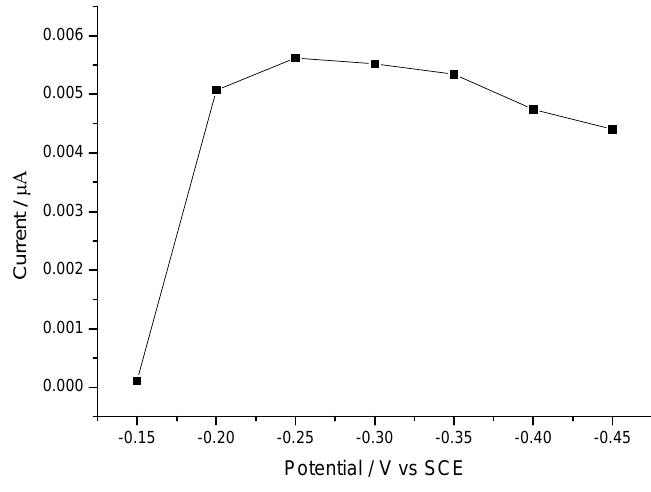
Figure 3. Effect of working potential on the response of the biosensor. Experimental conditions: 0.05 mM H